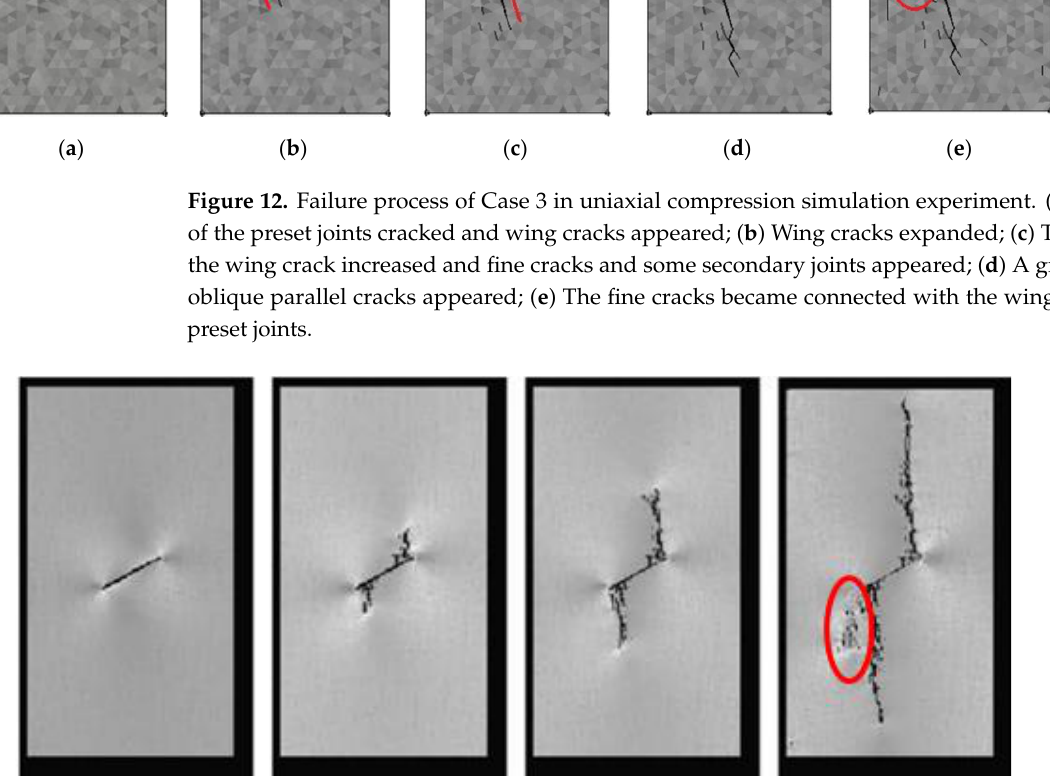
Figure 13. Expansion law of joints simulated in RFPA-2D.